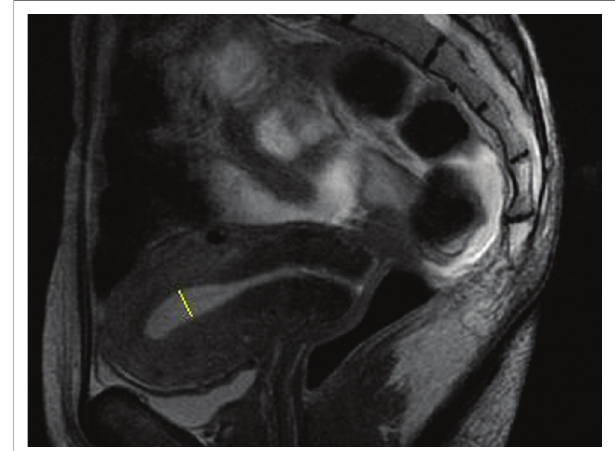
FIGURE 2: Sagittal FSE T2-weighted magnetic resonance (MR) image. The endometrium is well-defined, and a caliper is placed to measure the endometrial